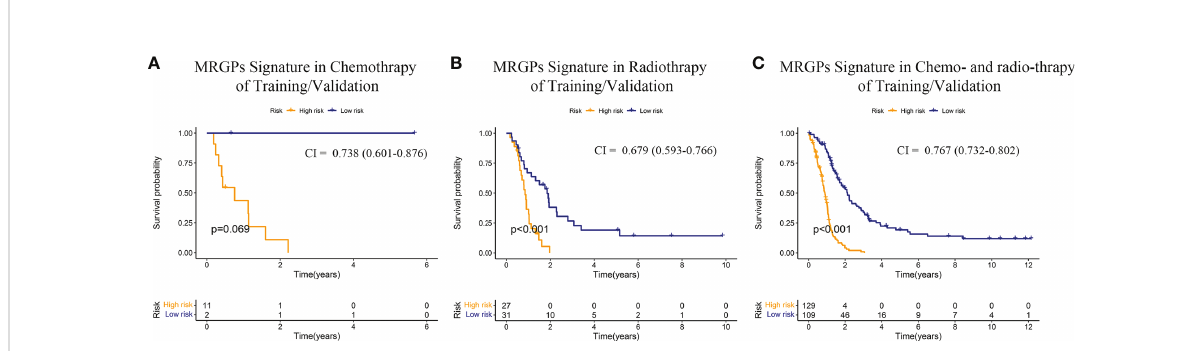
FIGURE 3 Kaplan – Meier Overall Survival Curve Analysis of the Responses of IDH WT GBM With Different MRGP Risks to Chemotherapy/Radiotherapy. Patients from the training and validation datasets were integrated into a meta-dataset. Patients receiving chemotherapy only (A) , radiotherapy only (B) , and radiotherapy combined with chemotherapy (C) were further divided into high- and low-risk groups based on the MRGP score. Kaplan – Meier overall survival curves were generated to show the risk strati fi cation of the prognostic model. CI indicates the C-index, which was used to evaluate the accuracy of the prognostic model in datasets. The performance of the MRGP model in the combination therapy group (CI = 0.767, P < 0.001) was superior to that in the single therapy groups (Chem, CI = 0.738, P = 0.069; Radio, CI = 0.679, P <